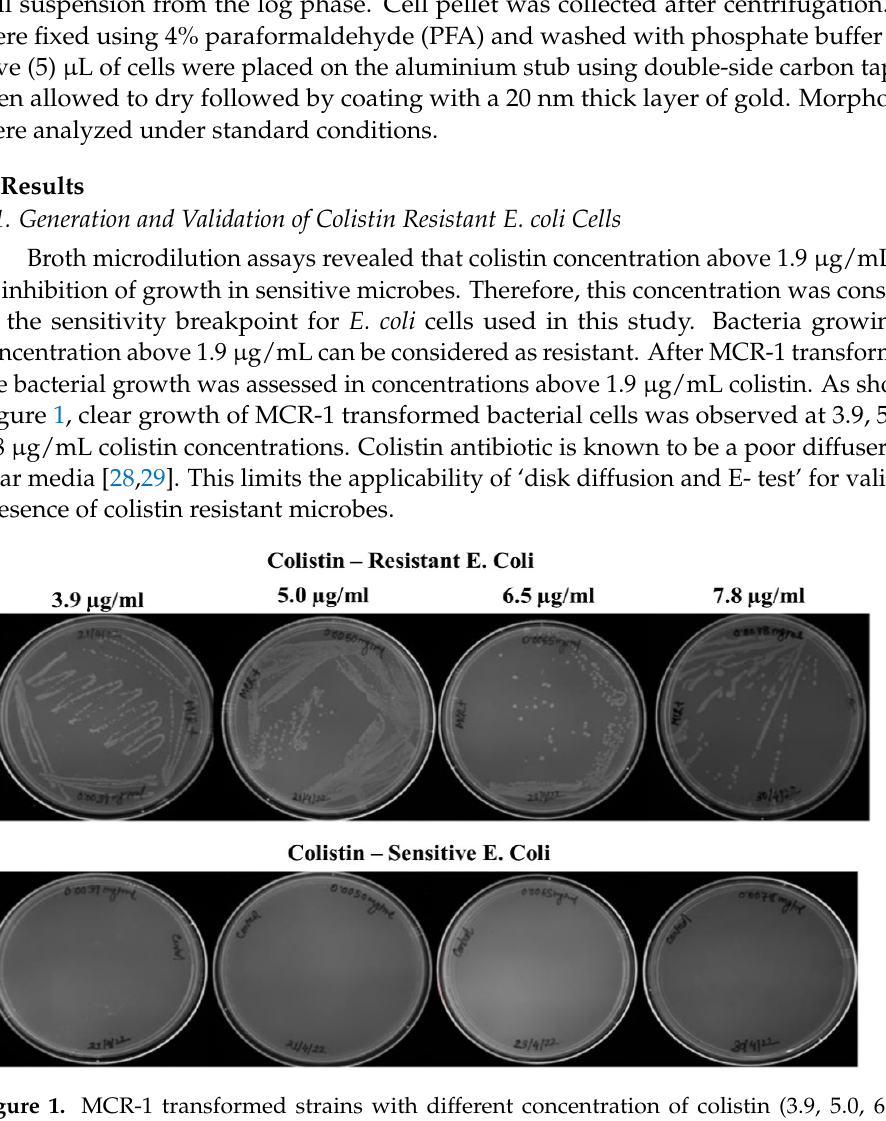
7.8 µ Figure 1. MCR-1 transformed strains with different concentration of colistin (3.9, 5.0, 6.5, and 7.8 µg/mL).